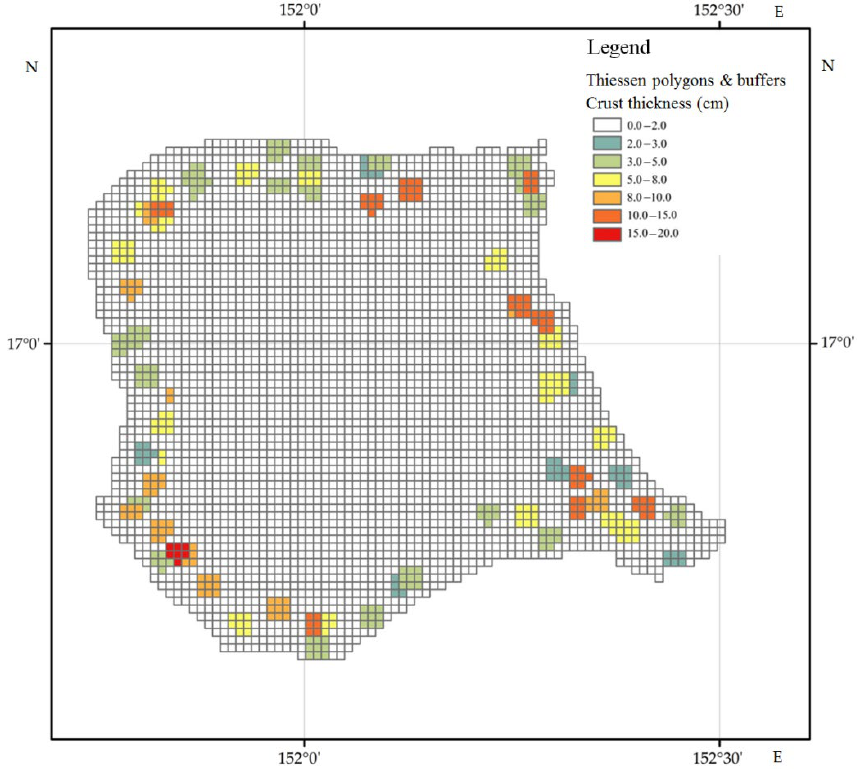
Figure 9. Grid unit assignment using the adjacent area method.